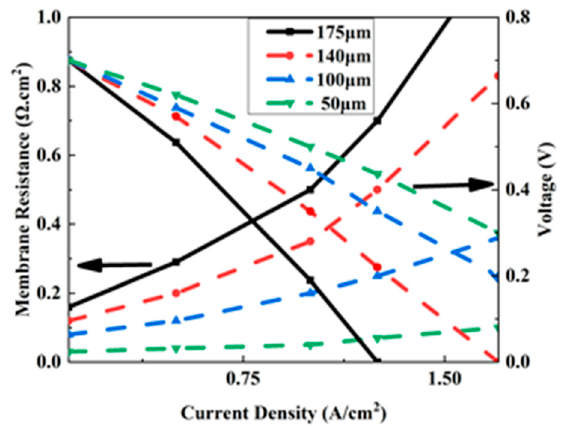
Figure 7. Cell voltage and membrane resistance vs. current density for different membrane thicknesses with catholyte concentration held constant at 35 g L − 1 NaCl.